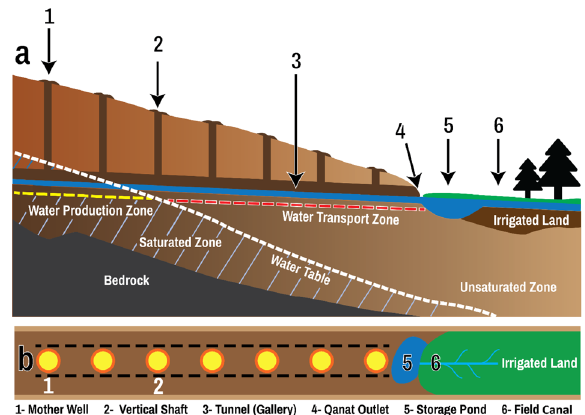
Fig. 4 A simple schematic showing a typical qanat system. a Cross- section: Using simple hand tools, the “ mother well ” is dug by a crew of skilled qanat diggers to a level below the groundwater table to locate the water table and assess the quality, quantity, and regularity of the groundwater fl ow. The mother-well depth depends on the water table depth, qanat length, earth slope, and the owner capital for excavation, ranging between 30 m and 100 m. Between the mother-well and qanat outlet, the crew digs vertical shafts at intervals of ∼ 20 to 200 m, with a diameter of 80 and 100 cm. The shafts are used for removing excavated materials from the tunnel, ensuring air circulation, and providing access for repair and maintenance. b Aerial view: Tunnel lengths in the Qanat range from a few hundred meters to 100 kilometers, with gradients ranging from 2/1000 to 5/1000. At the outlet, qanat discharge varies from 0.001 to 300 m 3 per hour (on average, 60 m 3 per hour). Edited by Microsoft